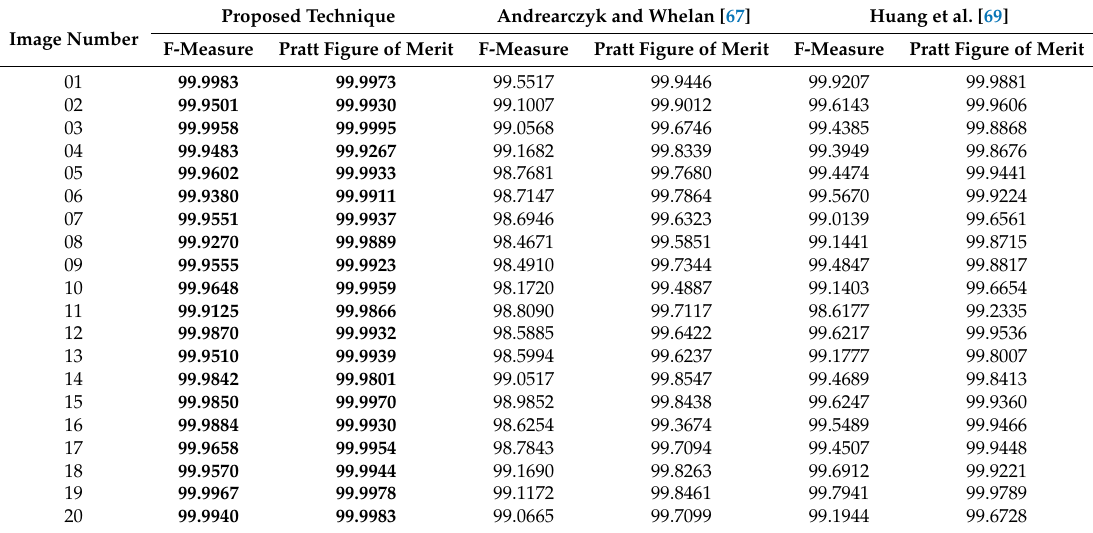
Table 4. F-measure and Pratt Figure of Merit for the benchmark images from the Prague Texture Datagenerator and Benchmark [70]. The measures are expressed as percentage values. The best results for each image are highlighted in bold.